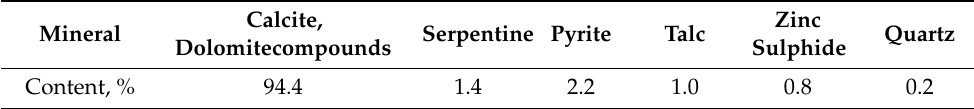
Figure 2. Electro-hydraulic servo compression testing machine.